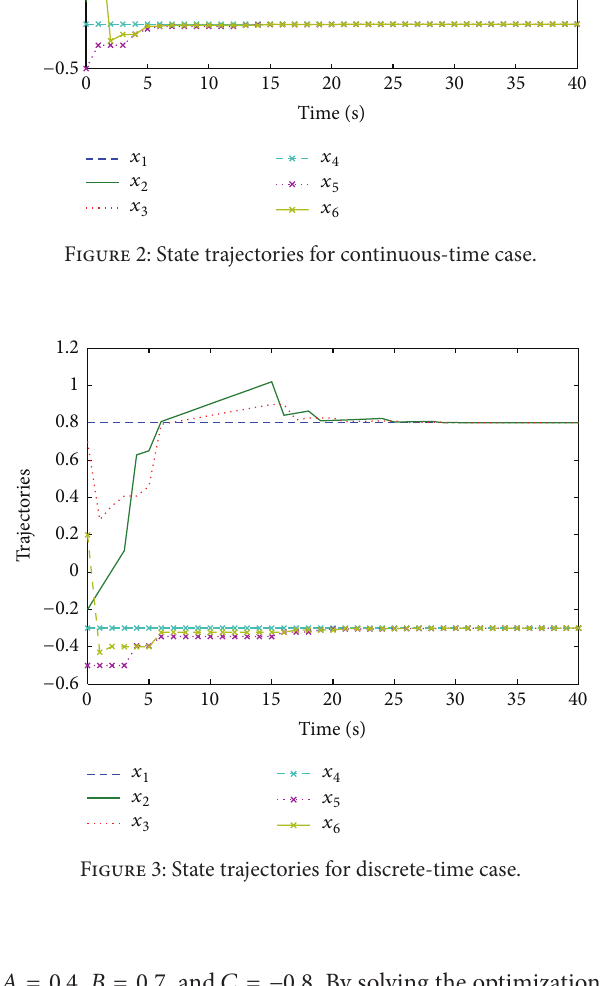
𝐴 = 0.4 , 𝐵 = 0.7 , and 𝐶 = −0.8 . By solving the optimization problem in Algorithm 16, we obtain 𝛾 = −0.2531